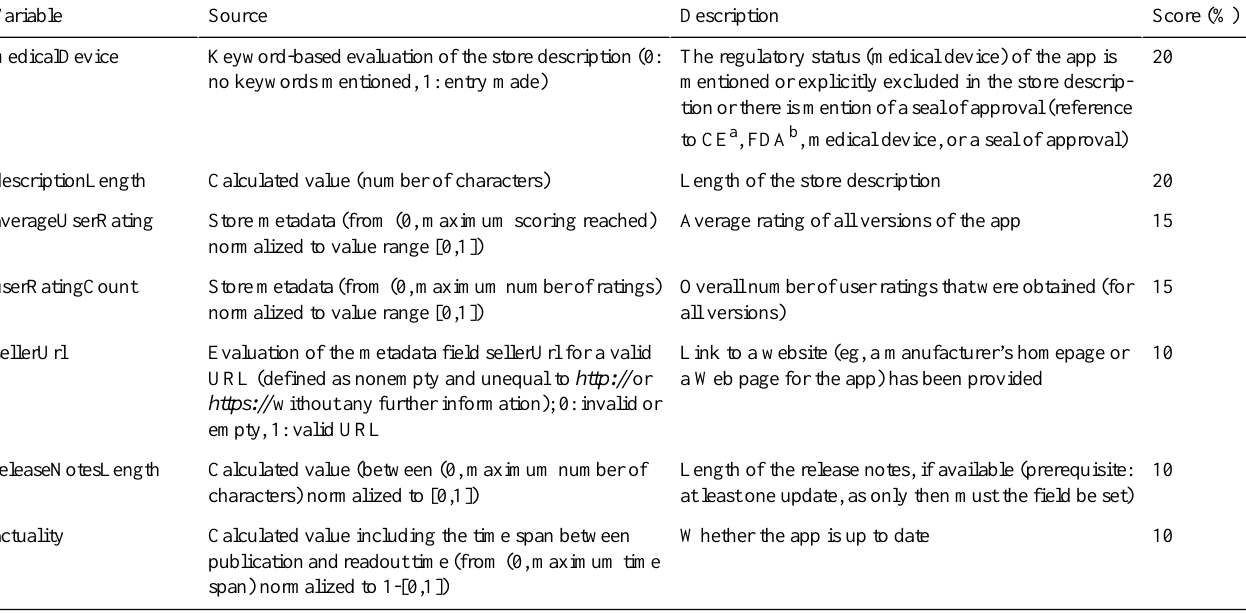
Table 4. Ranking criteria with weighting factor (percentage of the overall score), item name, description and condition to be fulfilled, or their explanation.